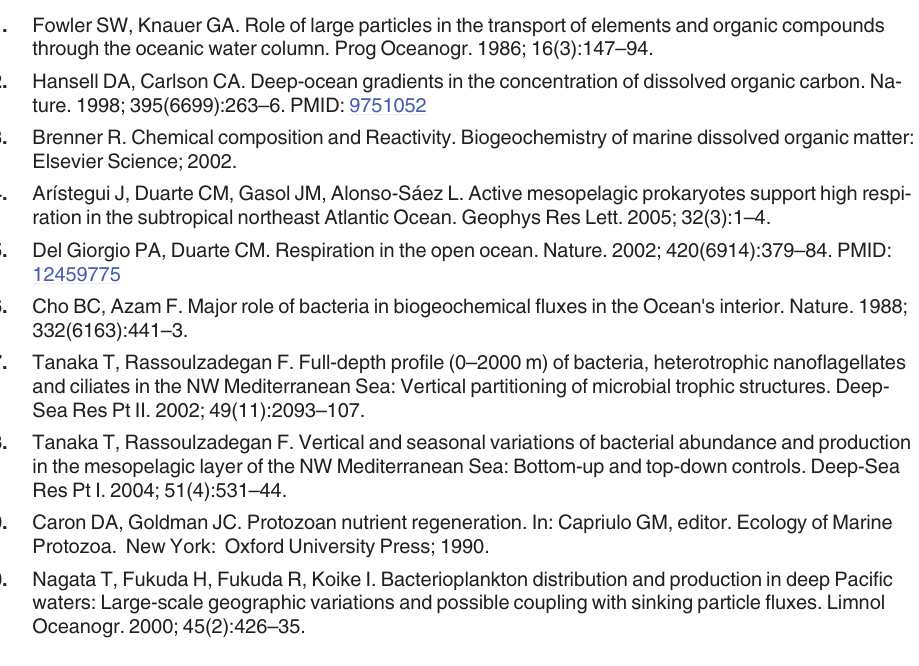
S1 Fig. Eukaryote counts (cells (cid:1) ml -1 ) taken at 0 and 48 hours. Fig A: Station 2, Fig B: Station 7, Fig C: Station 23. S2 Fig. Prokaryote to eukaryote ratio at 0 hours for stations 2, 7 and 23. Error bars represent the standard deviation of the mean (n = 2). S3 Fig. Grazing rates (prokaryotes grazed per eukaryote per hour) at stations 2, 7 and 23. Error bars represent standard deviation of the mean (n = 2). S1 Table. Table comparing prokaryote and eukaryote counts (at time = 0 hours), communi- ty grazing rates and per eukaryote grazing rates. Error values represent standard error of the